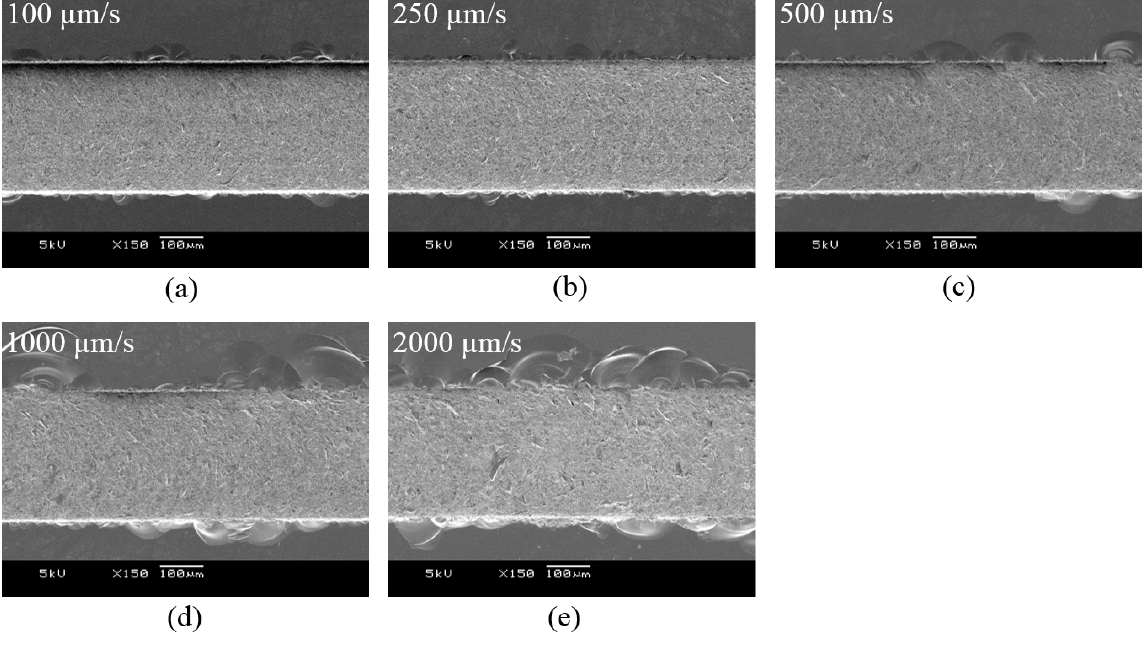
Figure 4. SEM images of the channels with different feed rates ( a ) 100 µm/s, ( b ) 250 µm/s, ( c ) 500 µm/s, ( d ) 1000 µm/s, ( e ) 2000 µm/s (depth of cut: 5 µm; 50,000 rpm).